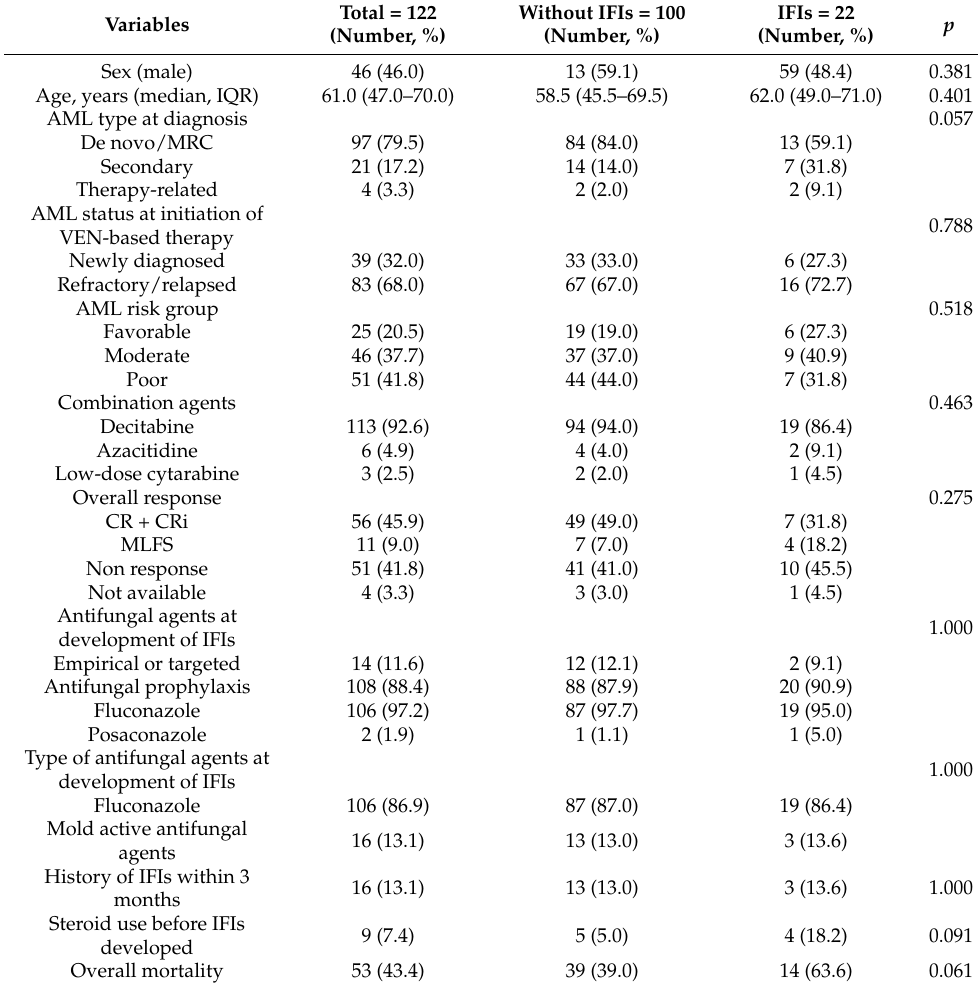
Table 2. Characteristics in patients according to invasive fungal